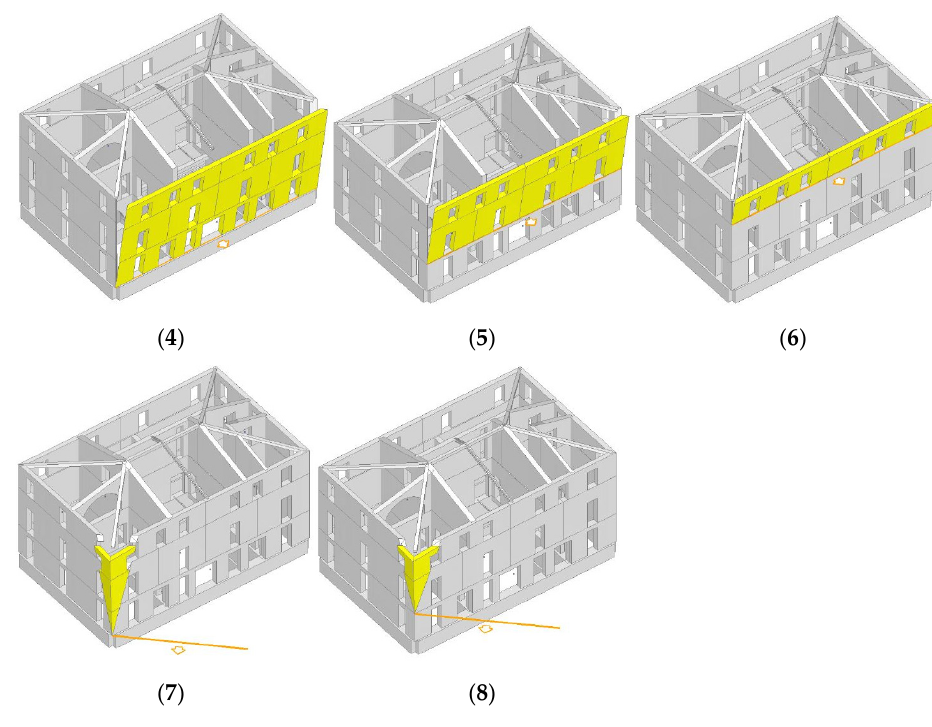
Figure 7. Local collapse mechanisms.